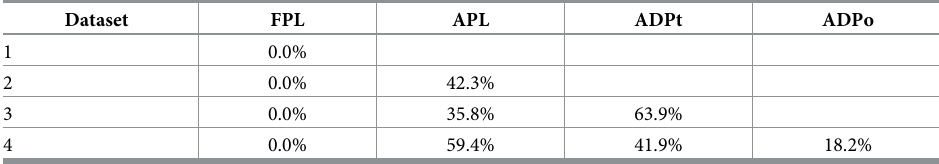
Table 3. Percent volume overlap associated with groups of high or low maximum isometric force for a given thumb muscle.